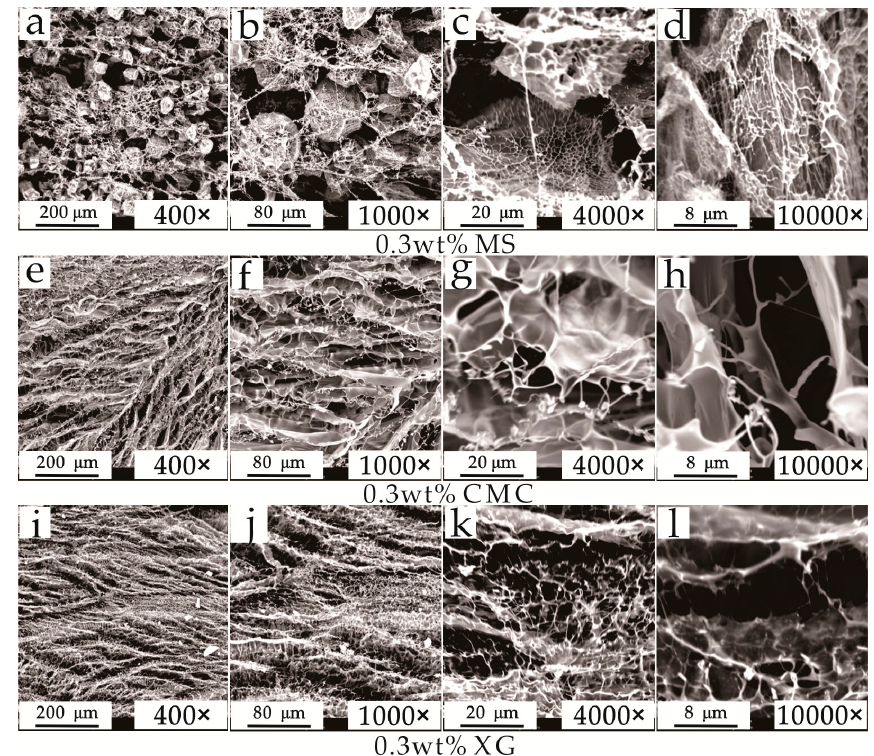
Figure 4. Mesostructures of 0.3 wt% ( a – d ) modified starch (MS), ( e – h ) carboxymethylcellulose sodium (CMC), and ( i – l ) xantham gum (XG) solutions.